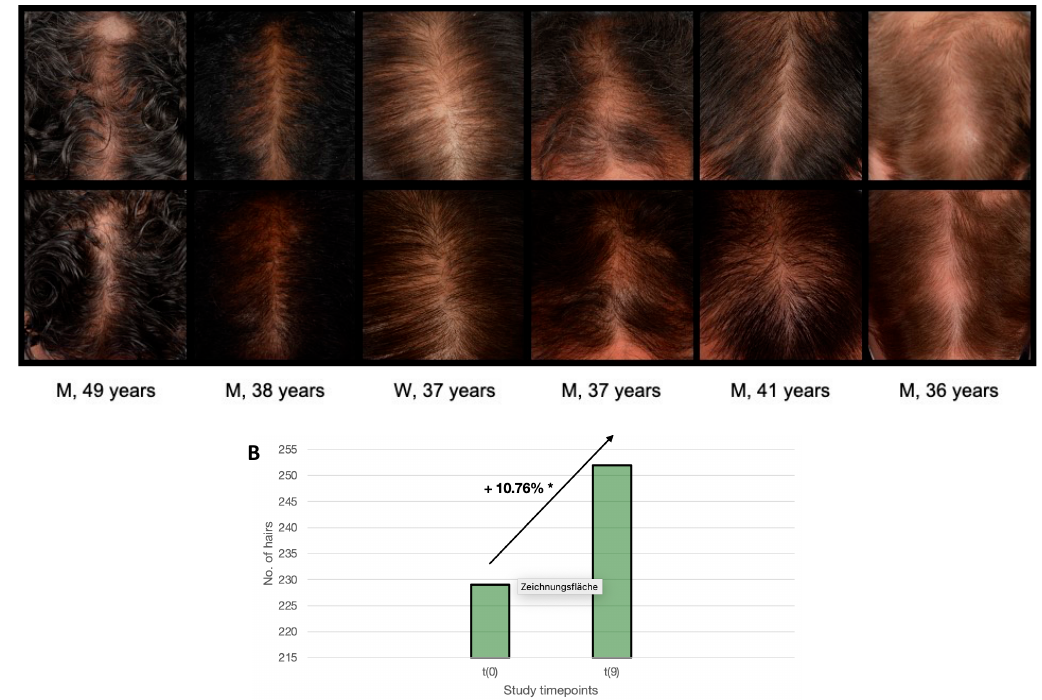
Figure 4. Tomorrowlabs [HSF] hair restoration significantly increases hair growth. ( A ) Clinical examples of macroscopic hair growth improvement in the study period. ( B ) After 9 months of treatment, an increase in hair growth of 10.76% on average in responsive patients was measured (* p <